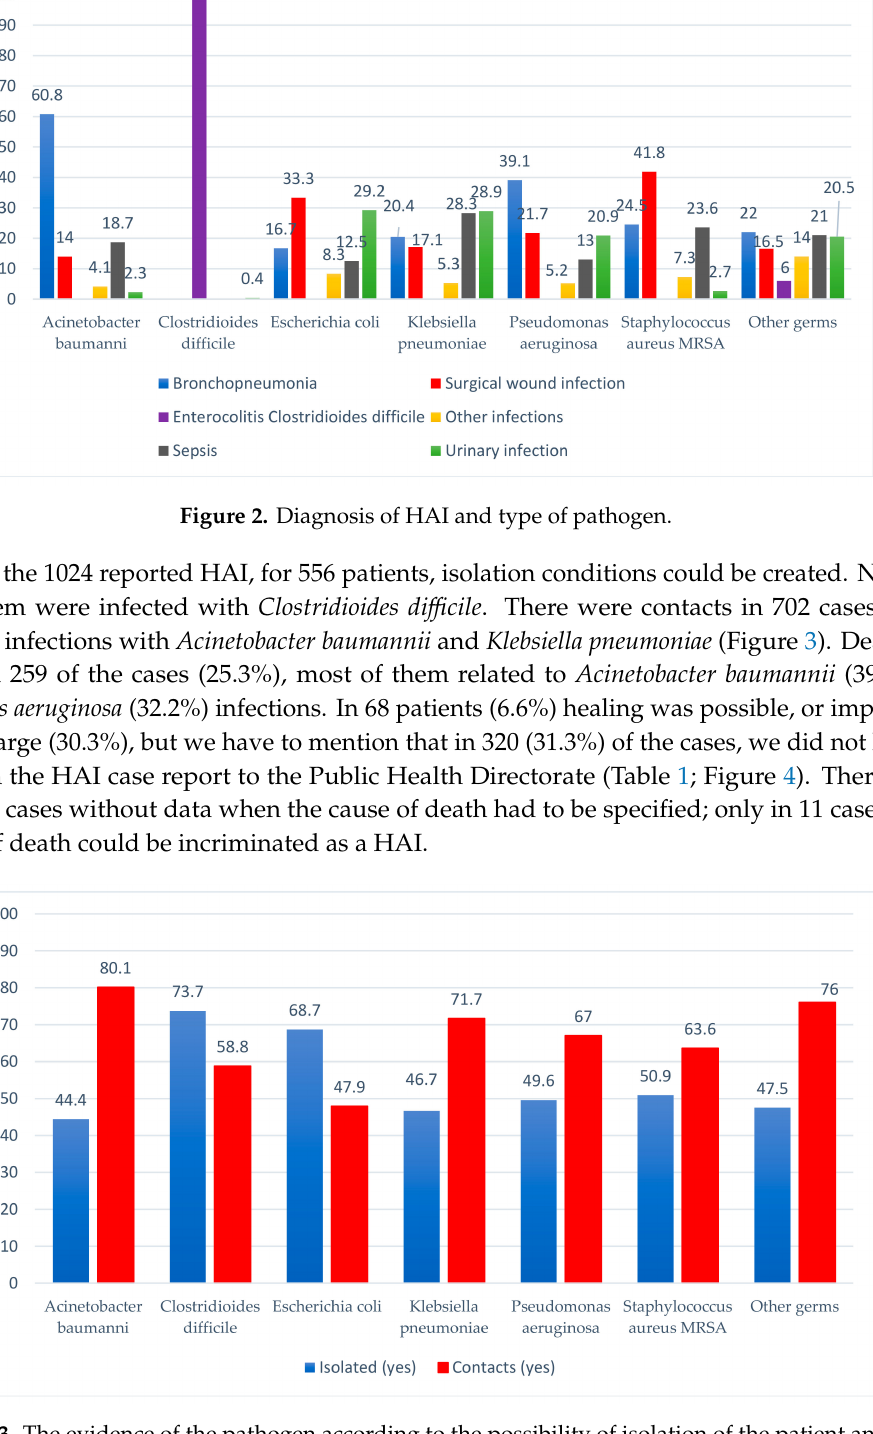
Figure 3. The evidence of the pathogen according to the possibility of isolation of the patient and the existence of